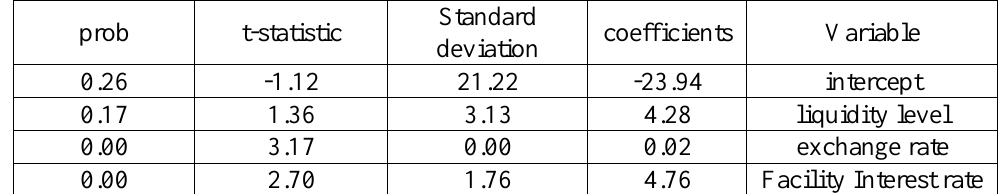
Table 6. The second equation results: Inflation rate as a dependent variable